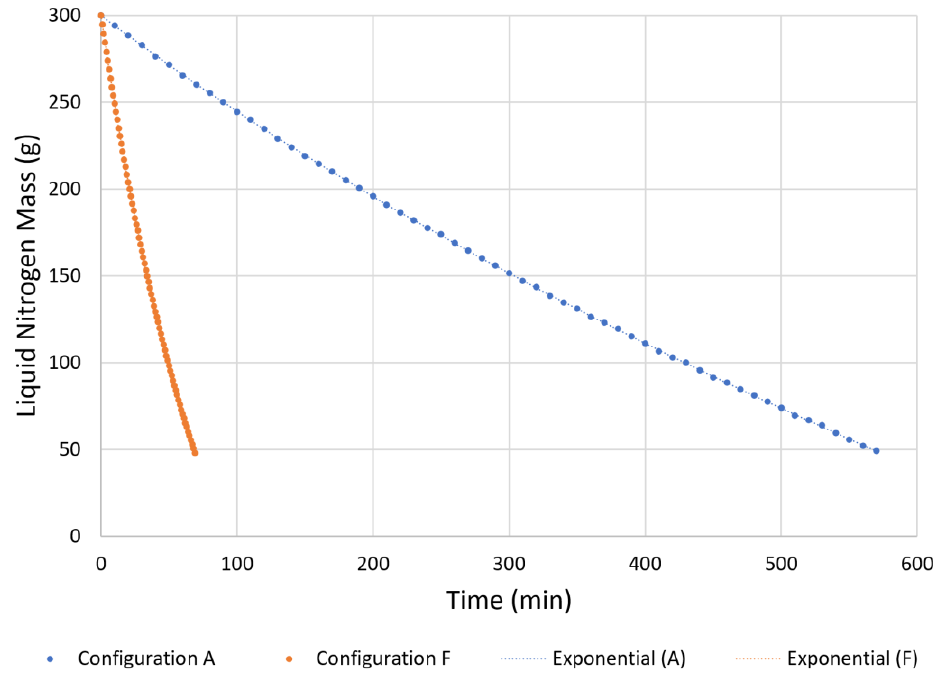
Figure 4. Evaporation rate of the baseline Dewar, configuration A, and the highest performing modified experimental Dewar, configuration F. Each curve is the average of four data runs, with data plotted in ten-minute increments for configuration A and one-minute increments for configuration F. Each data point’s associated y-axis SD is contained in Appendix A. Both curves start at 300 g of LN2 and continue until the first averaged data point is less than or equal to 50 g of LN2.